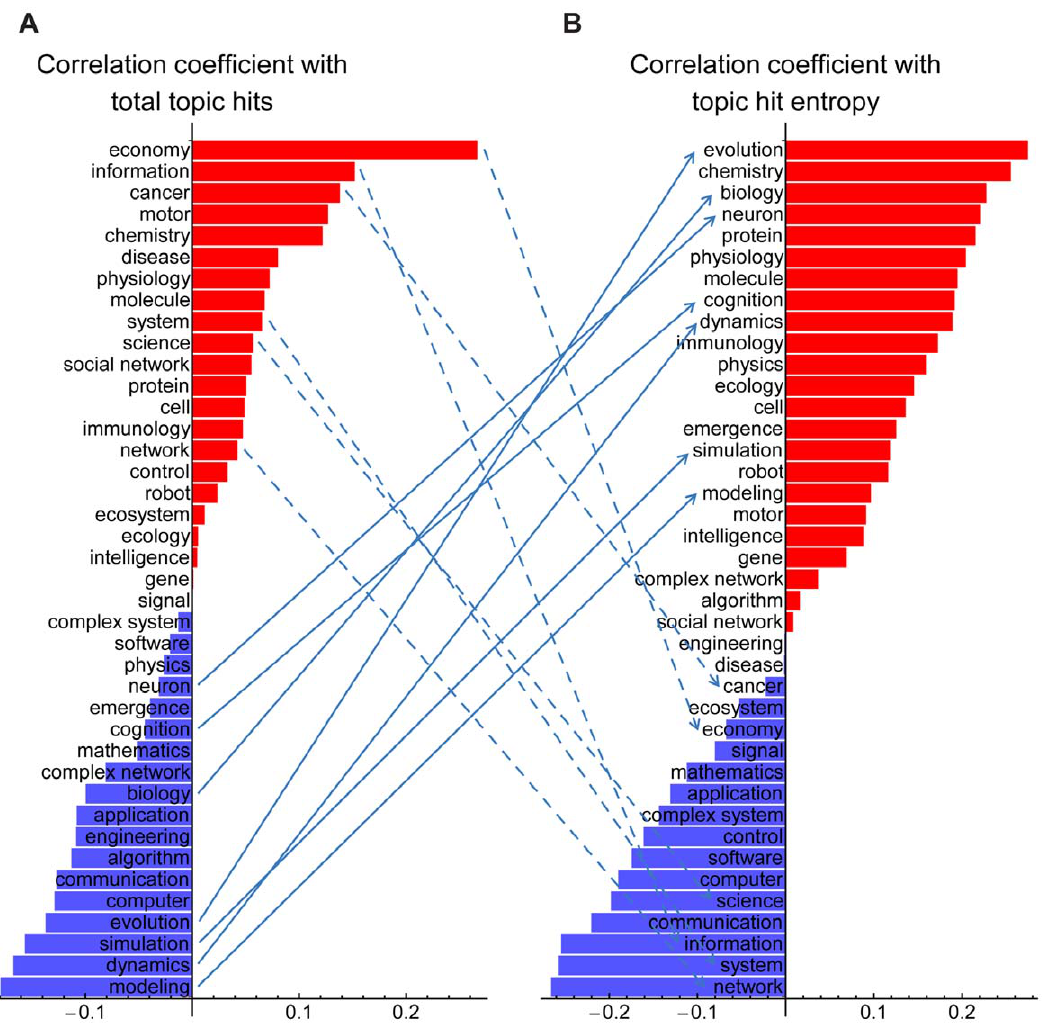
Figure 5. Correlations between the visibility boost of each research topic and a researcher’s overall popularity (total topic hit, A) and individual-level interdisciplinarity (topic hit entropy, B). Upward or downward moves of topics from A to B by 20 or more places in the ranking are indicated by solid and dashed arrows, respectively.